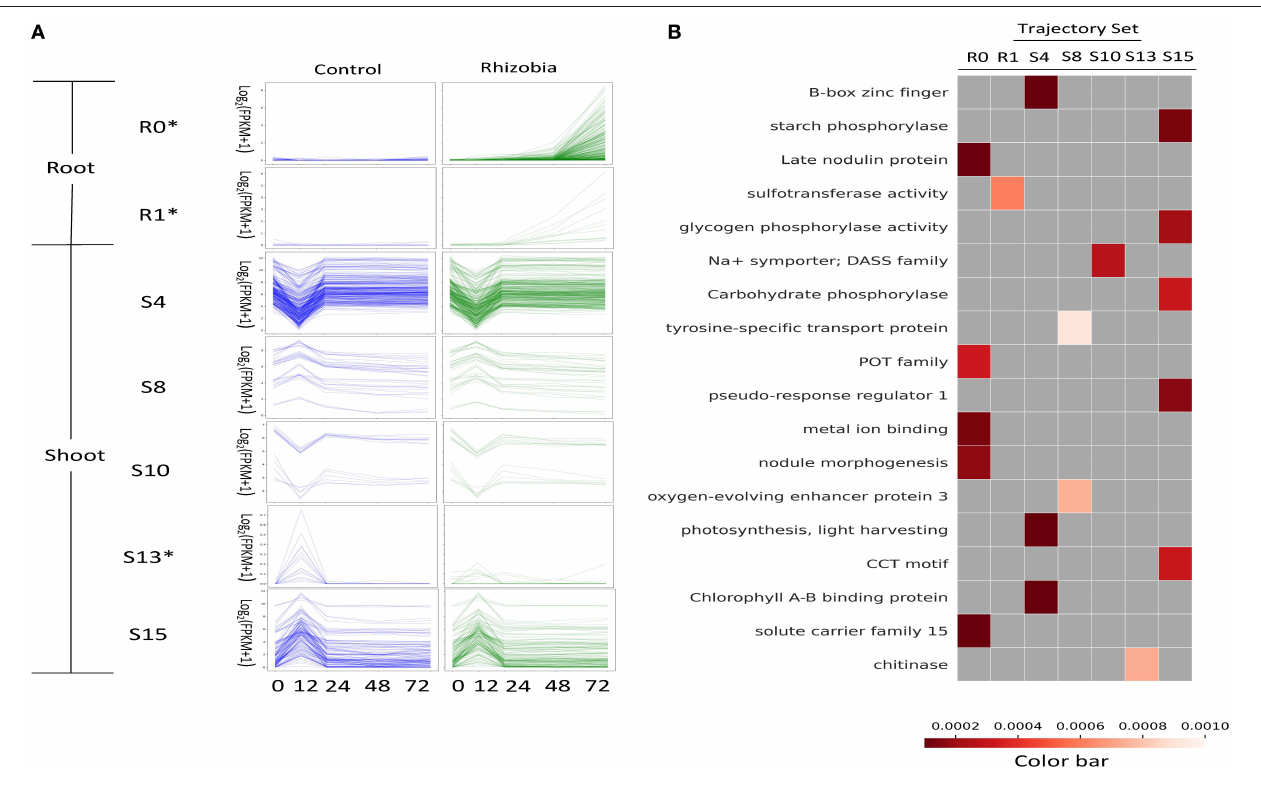
FIGURE 4 | Functional enrichment of GeneShift output. (A) Expression profiles of several enriched GeneShift trajectory sets corresponding to Figure 3 . Control uninoculated is blue, and inoculated with rhizobia is green. The unit of the y-axis is log2 (FPKM+1), and the unit of the x-axis is time (h) after rhizobia inoculation. Each thin line represents one replicate. The asterisk next to the trajectory set name indicates the pattern shifting between two conditions. (B) Gene Ontology, KEGG, fragments per kilobase of gene per million read pairs (FPKM) enrichment analysis of genes assigned to each trajectory set with Benjamini and Hochberg corrected p < 0.001. Each column of the heatmap indicates one trajectory set; each row presents one enriched